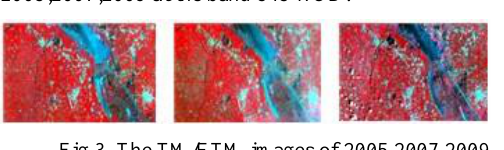
Fig.3. The TM/ETM images of 2005,2007,2009 at the band 543-RGB